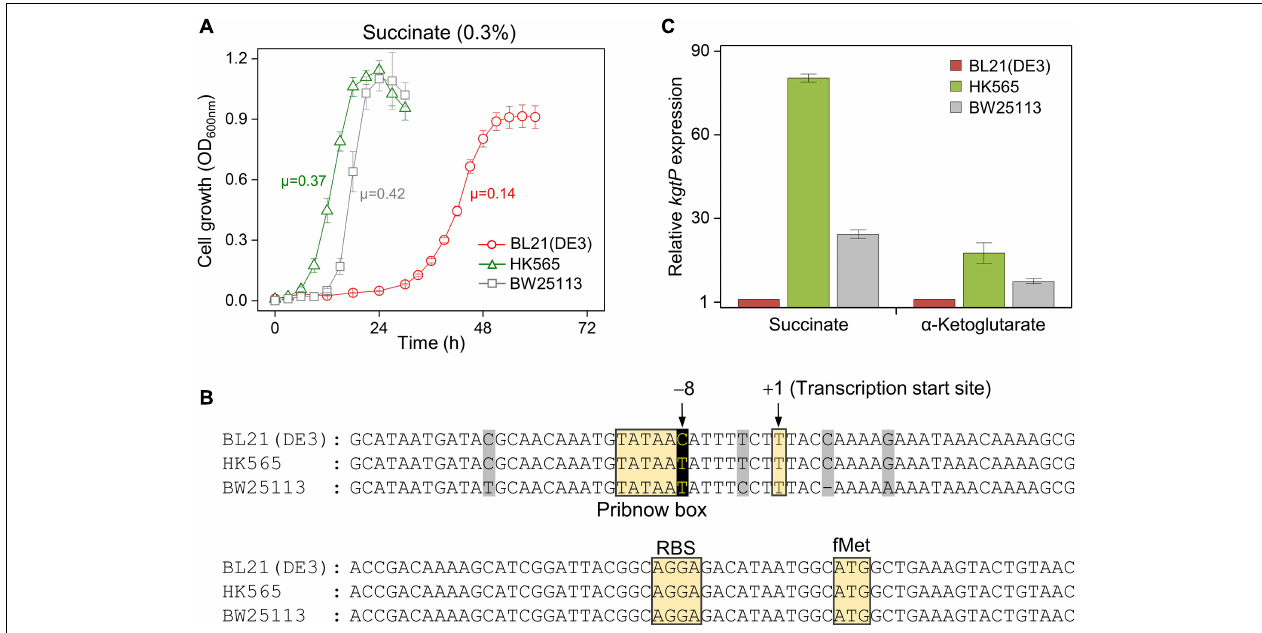
FIGURE 3 | Characterization of the HK565 cells adapted in succinate minimal medium, compared to the BW25113 and parental BL21(DE3) strains. (A) Growth profiles of the HK565, BW25113, and BL21(DE3) strains. The unit of specific growth rate ( µ ) is h - 1 . (B) Nucleotide sequence alignment of the promoter region of the kgtP gene in the HK565, BW25113, and BL21(DE3) strains. The nucleotides that evolved from C to T at the – 8 position of HK565 are shown in black. Unconserved nucleotide sequences are shaded in gray. (C) RT-qPCR analysis of the expression levels of kgtP in cells grown in M9 medium containing succinate or α